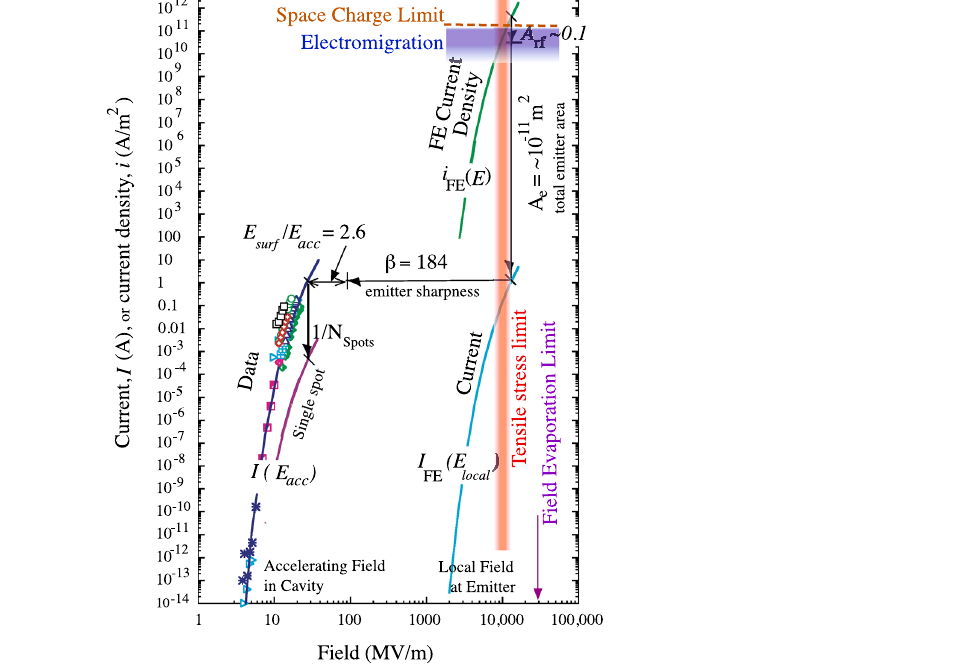
In RF experiments, the average values of accelerating fields can be determined from the geometry and applied power. The local field at the breakdown location is more difficult to determine but can be measured from the dependence of field emitted current on electric field, which depends on the exponent n , I FE ∼ E n . The values of electric field for cavities and local models are shown in Fig. 4 9 . Local asperities enhance the local field on the surface by a factor